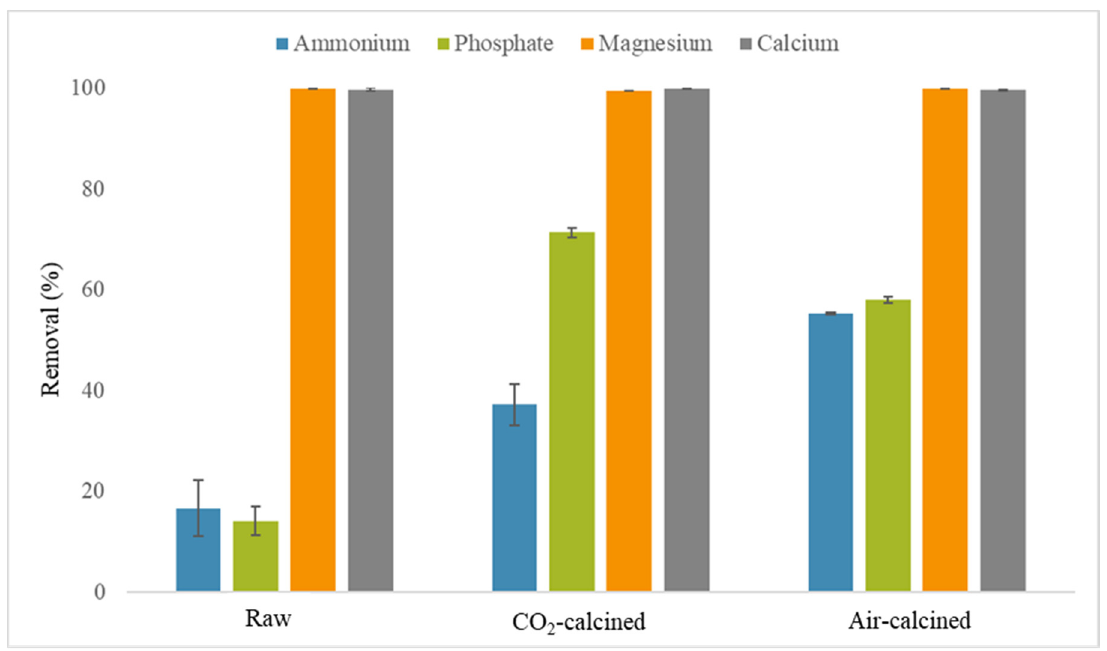
Figure 2. Ammonium, phosphate, magnesium, and calcium removal rates for the different treat- ment conditions using dolomite (Mg 2+ :NH 4+ :PO 43 − = 1.25:1:1.25; pH = 9.5). The error bars represent conditions using dolomite (Mg 2+ :NH 4 + :PO 4 3 − = 1.25:1:1.25; pH = 9.5). The error bars represent ± one ± one standard deviation for three replicate experiments. standard deviation for three replicate